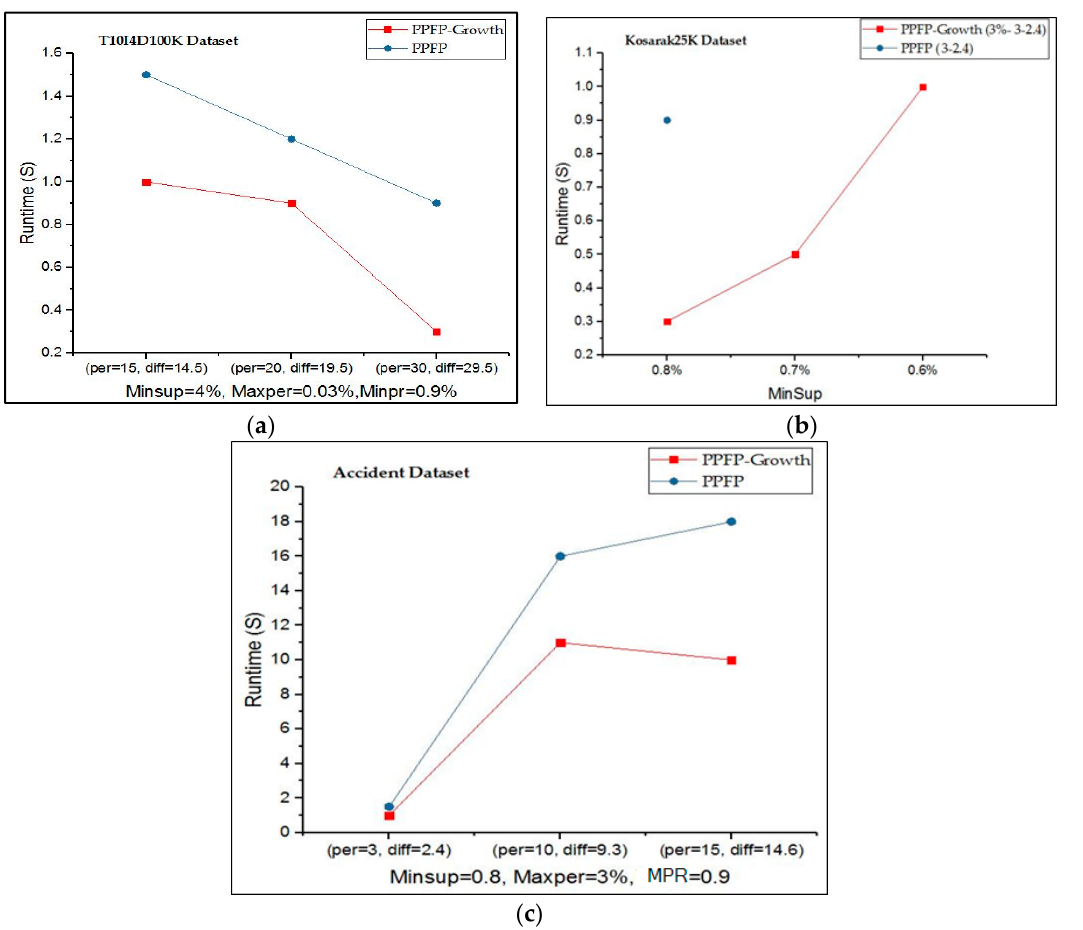
Figure 5. Execution time of PPFP-growth and PPFP. ( a ) Execution time on T10I4D100K dataset. ( b ) Execution time on Kosarak25K dataset. ( c ) Execution time on accident dataset.